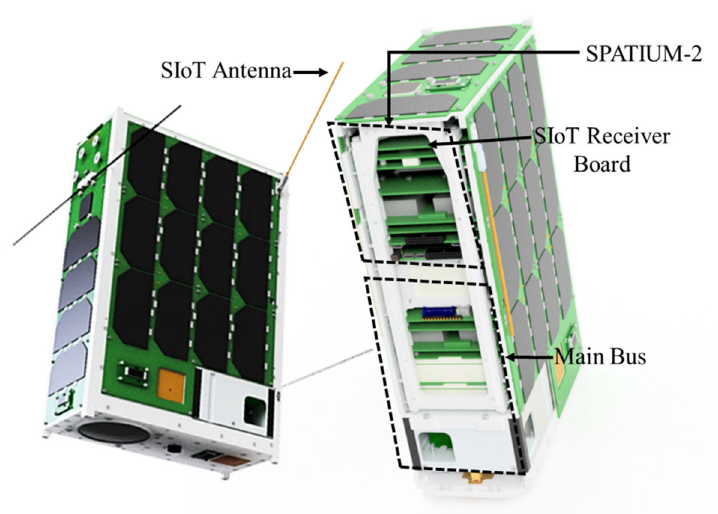
Figure 4. KITSUNE satellite configuration and internal arrangement.